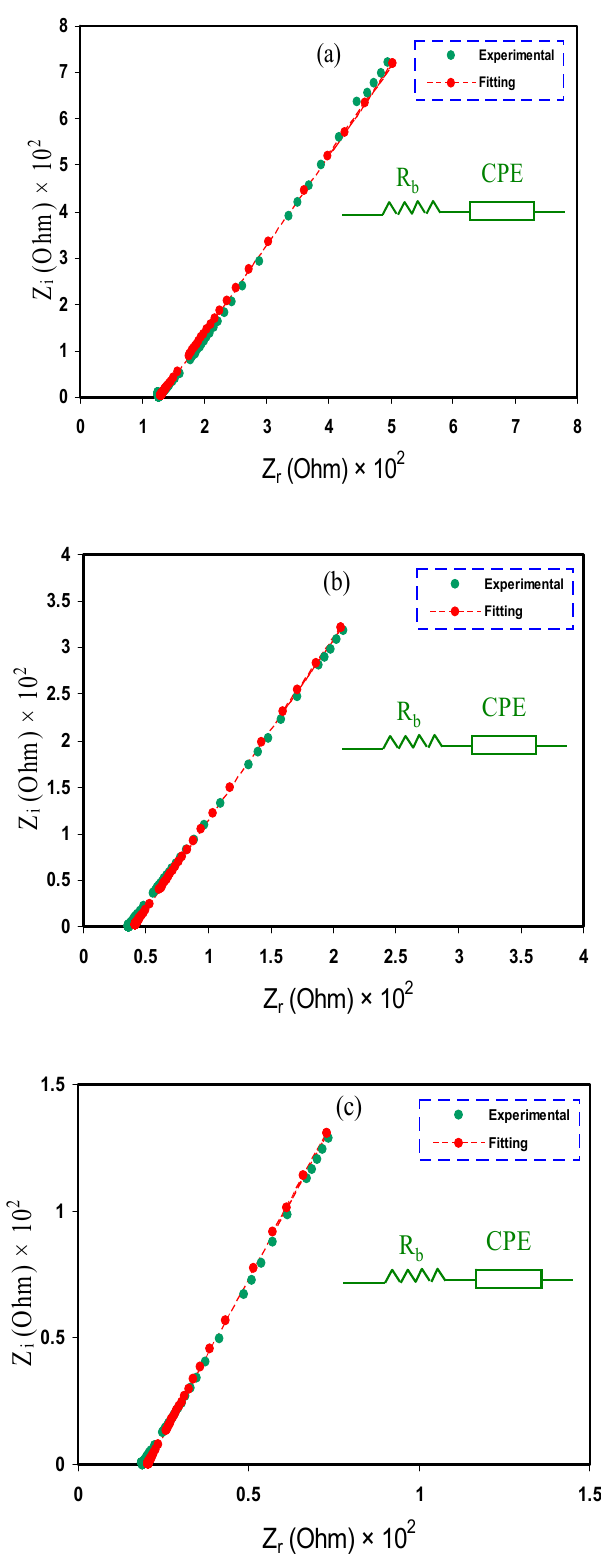
Figure 1. EIS plots for ( a ) PVCSG1, ( b ) PVCSG2, and ( c ) PVCSG3 electrolyte